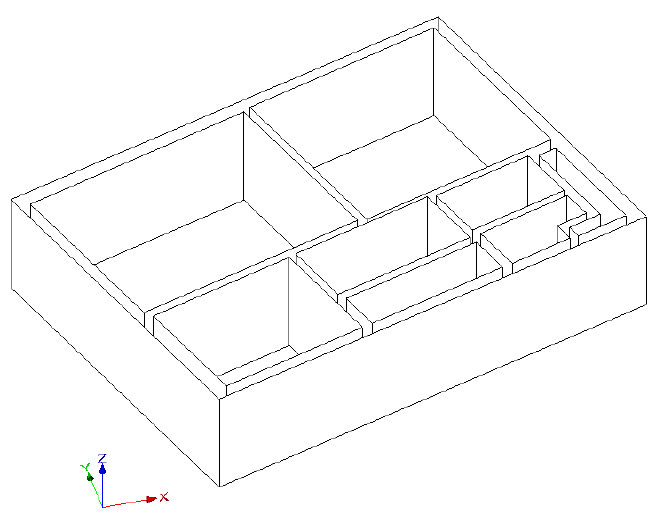
Figure 8. Plan C, extruded models viewed as CityGML.